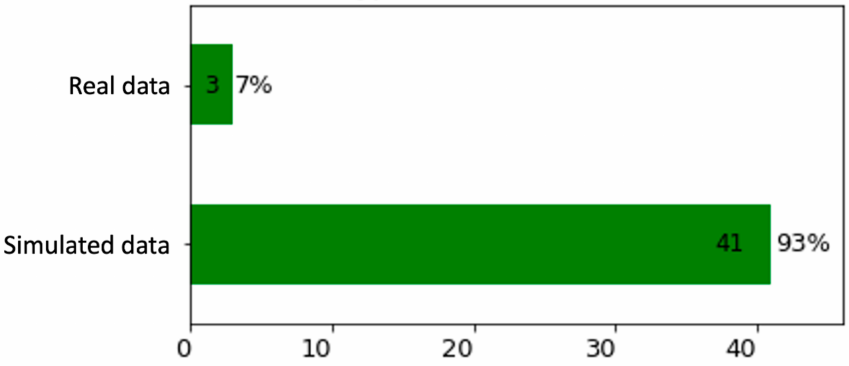
Figure 18. Breakdown of type of data for testing